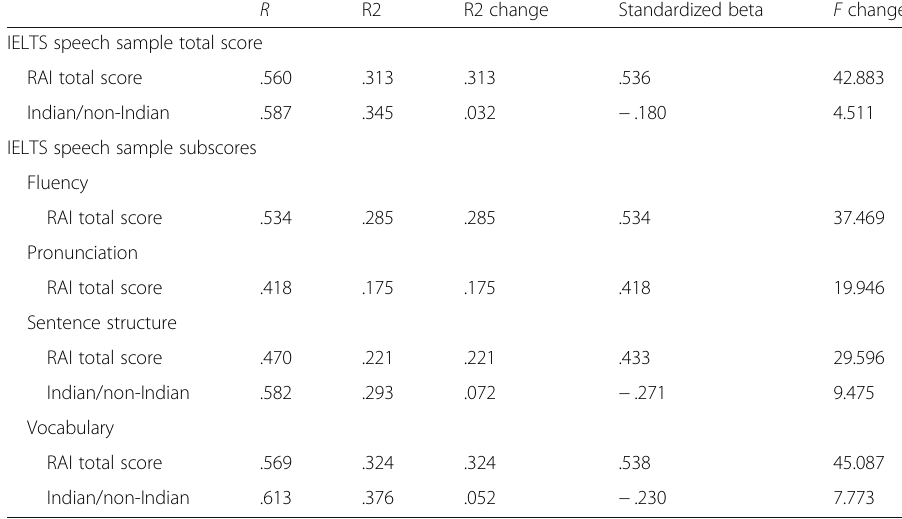
Table 6 Summary results of multiple regressions for rater attitude towards Indian English and background variables predicting ratings of IELTS speech samples R R2 R2 change Standardized